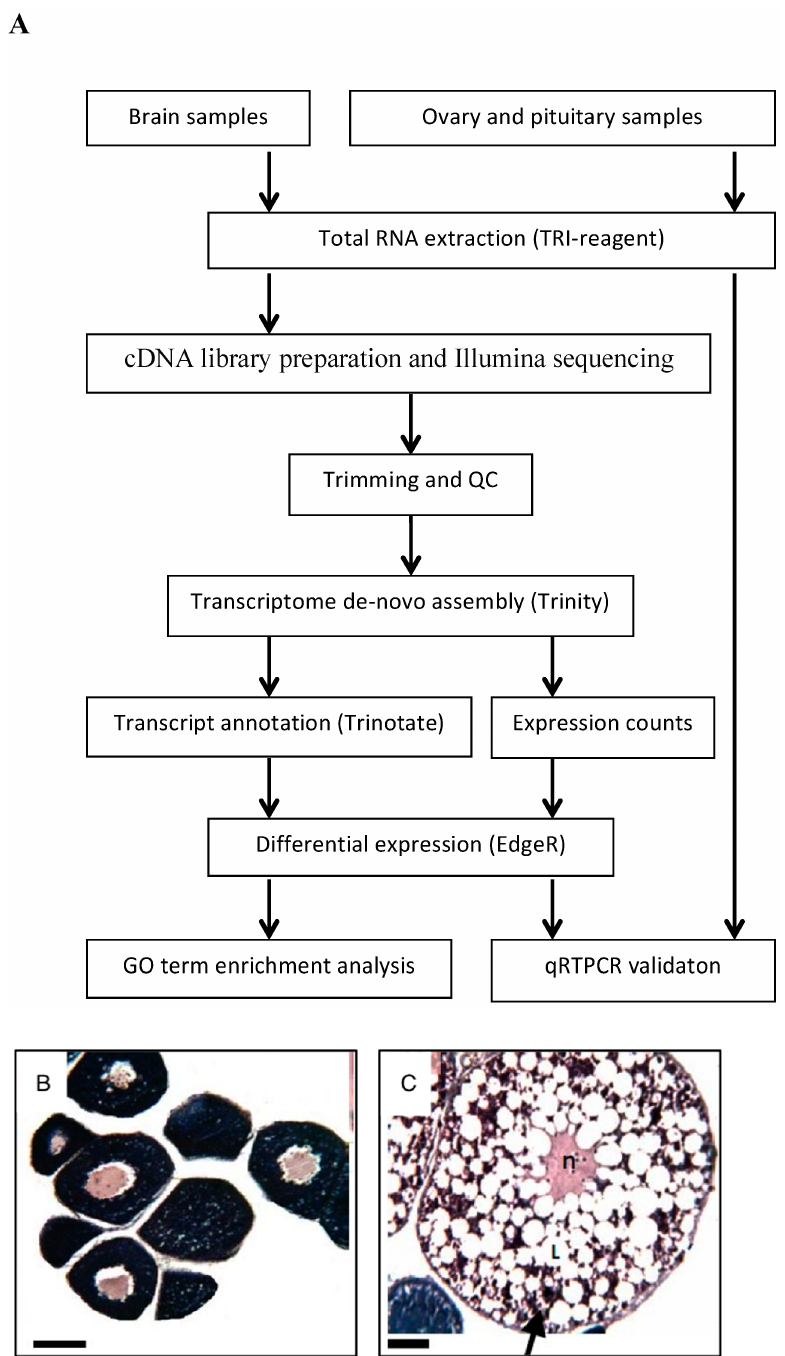
Figure 1. ( A ). General scheme of methods used in the present study. ( B , C ). Histology of gonadal samples from female blue gourami according to gonadal development stage. ( B ) Young females before vitellogenesis (PVTL). ( C ) Females at advanced stages of vitellogenesis (HVTL). Note the high concentration of yolk vesicles supplanting the periphery of the oocyte (black arrow) and the lipid vesicles (L). The oocyte nucleus is denoted by (n). Sections were stained with hematoxylin and eosin. Bar = 100 μ m.